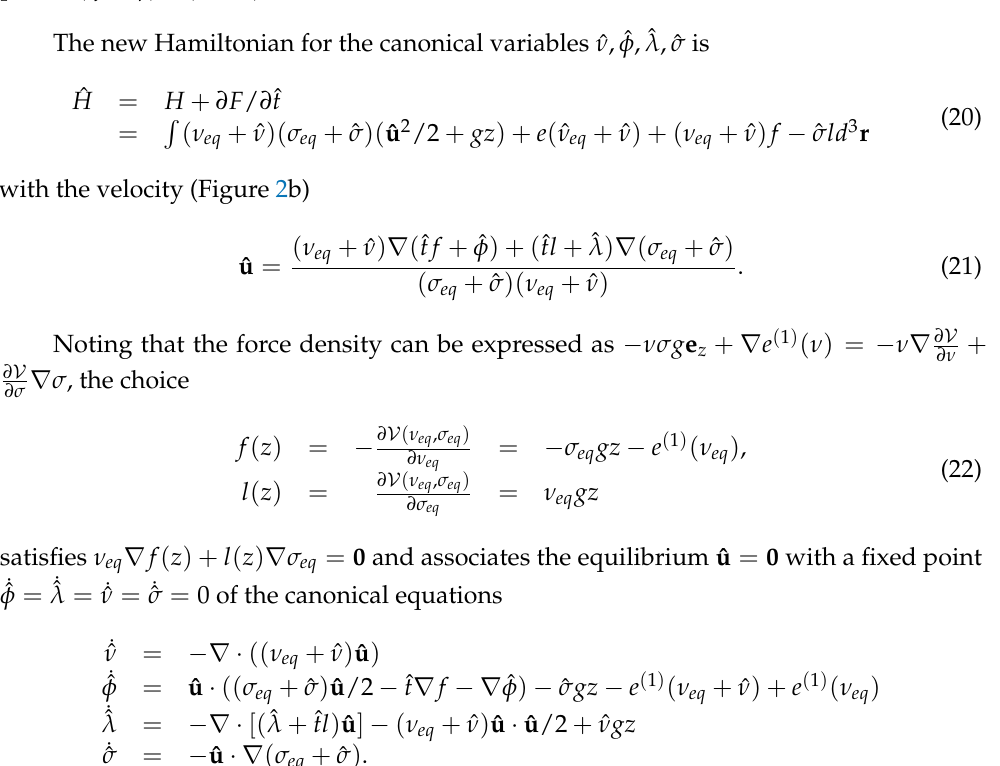
Figure 2. ( a ) Stationary state of a stratified fluid: the growing variables φ = ˆ tf and λ = ˆ tl yield a zero momentum field p = ν eq ˆ t ∇ f + ˆ tl ∇ σ eq = 0 . ( b ) Nonstationary state: the terms ˆ tf and ˆ tl are separated from the canonical variables as φ = ˆ tf + ˆ φ , λ = ˆ tl + ˆ λ , the momentum is p = ν ∇ ( ˆ tf + ˆ φ ) + ( ˆ tl + ˆ λ ) ∇ σ